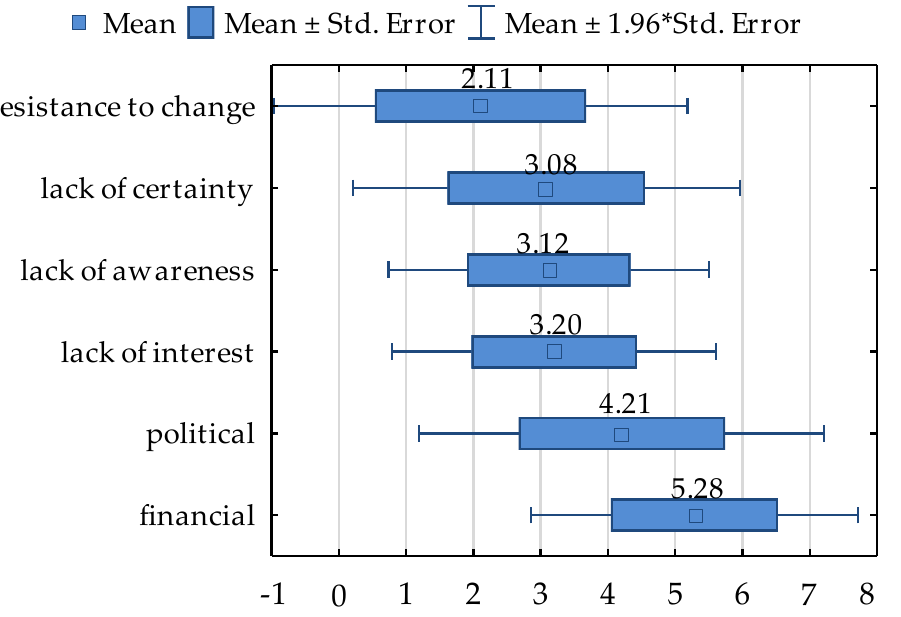
Figure 7. Average ratings of energy transition barriers. Source: own study N = 387.